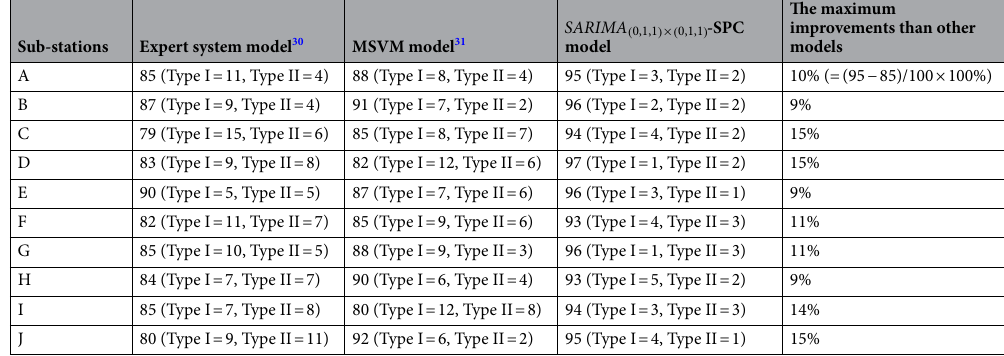
Table 5. The 100 detection results of the SARIMA ( 0,1,1 ) × ( 0,1,1 ) -SPC model and other potential models in different substations. Type I error is the sample size or percentage of normal status that are detected as failure status, i.e., the normal processes are misdiagnosed as the abnormal ones. Type II error is the sample size or percentage of failure status that are detected as normal status, i.e., the abnormal processes are misdiagnosed as the normal